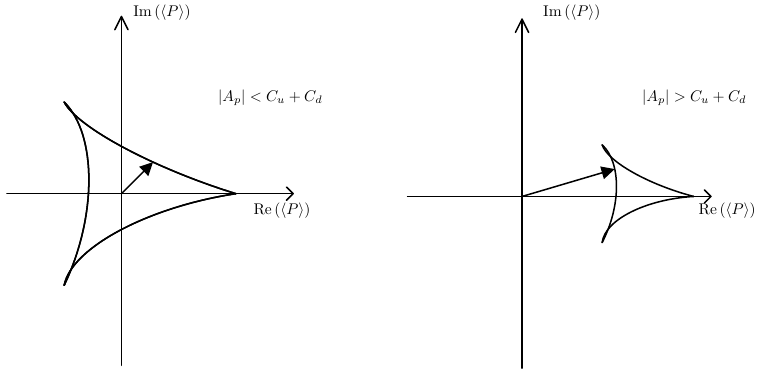
Figure 28 . An example when | A p | (cid:28) C q and C u < C d , the h P ( z ) i in ansatz eq. (3.14) depicted in the complex plane (the left panel) and arg( P ( z )) (the right panel).